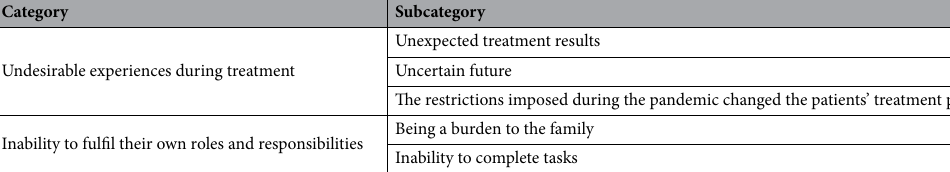
Table 2. Stressors among patients with breast and gynaecological